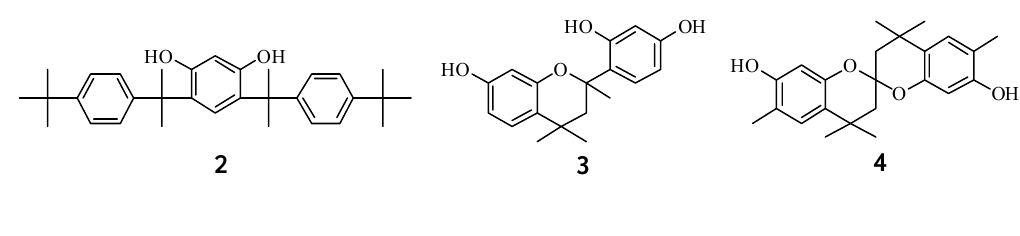
Figure 7 . Model compounds 2 , 3 , and 4